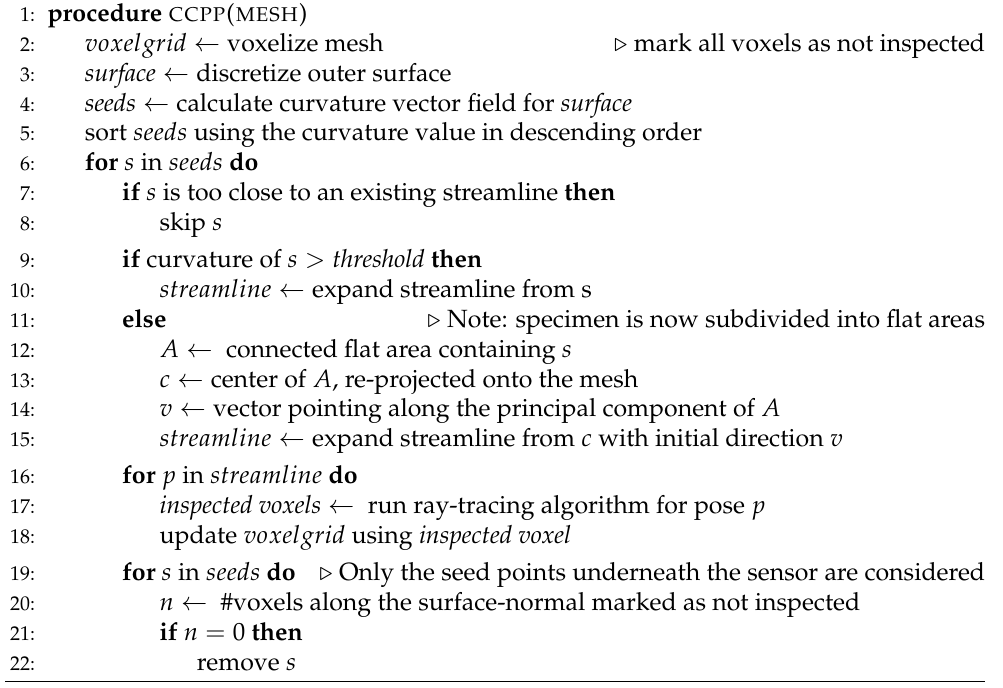
Algorithm 1 Cartesian coverage path planning